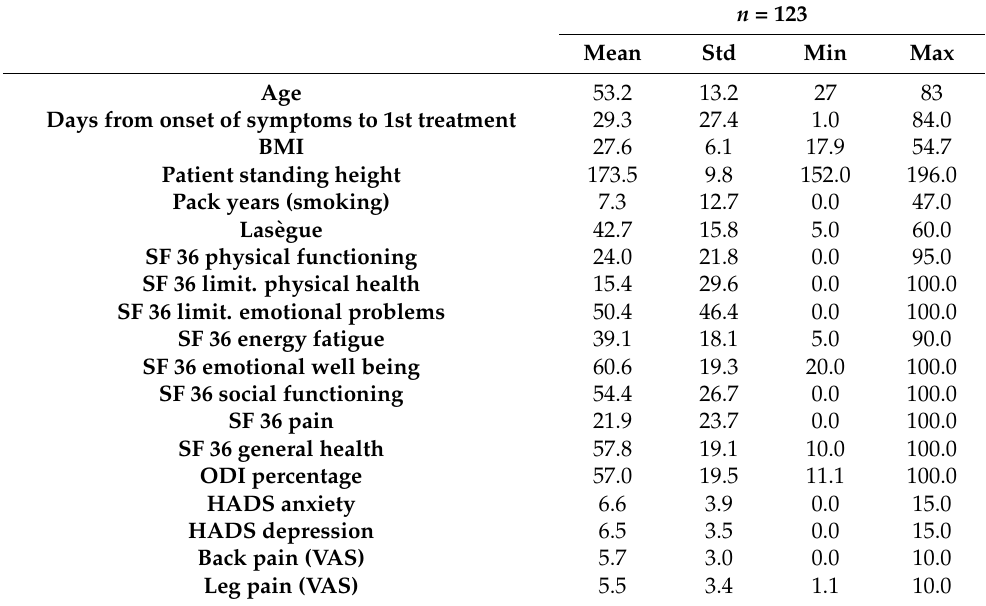
Table 1. Continuous patient data (demographic and clinical scores) on admission.